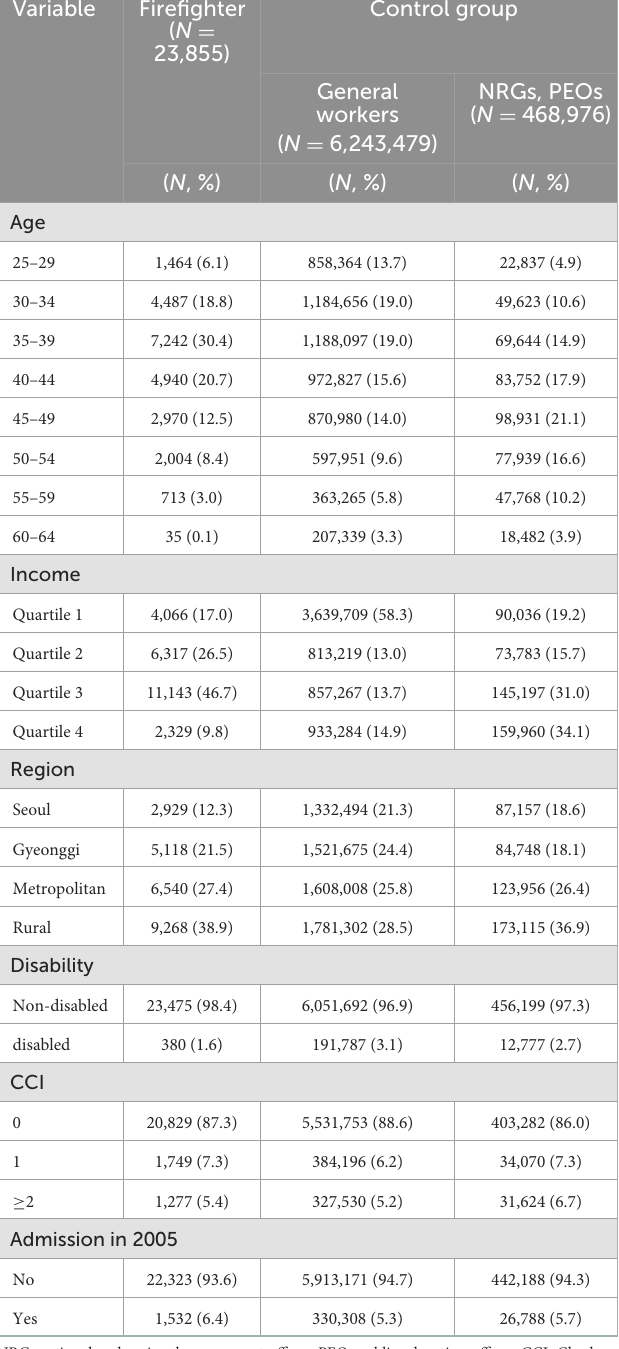
TABLE 1 Characteristics of the general